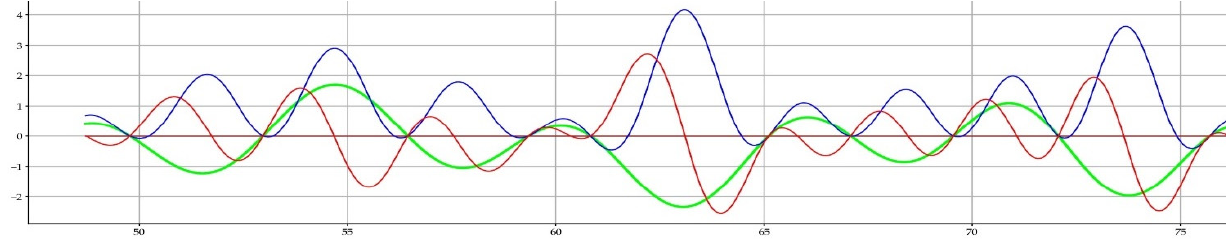
Figure 2. Plots of ζ ( 𝓈 ) (blue and red) and F ( 𝓈 ) (green & brown) on the CL L : (cid:61) ( F ( 1 / 2 + iy )) = 0. The frequency of the Figure 2. Plots of 𝜁(𝓈) (blue and red) and 𝐹(𝓈) (green & brown) on the CL ℒ : ℑ(cid:3435)𝐹(½ + 𝑖𝑦)(cid:3439) = 0 . The frequency of the waves of the F function is half that of the ζ waves of the 𝐹 function is half that of the 𝜁 function.